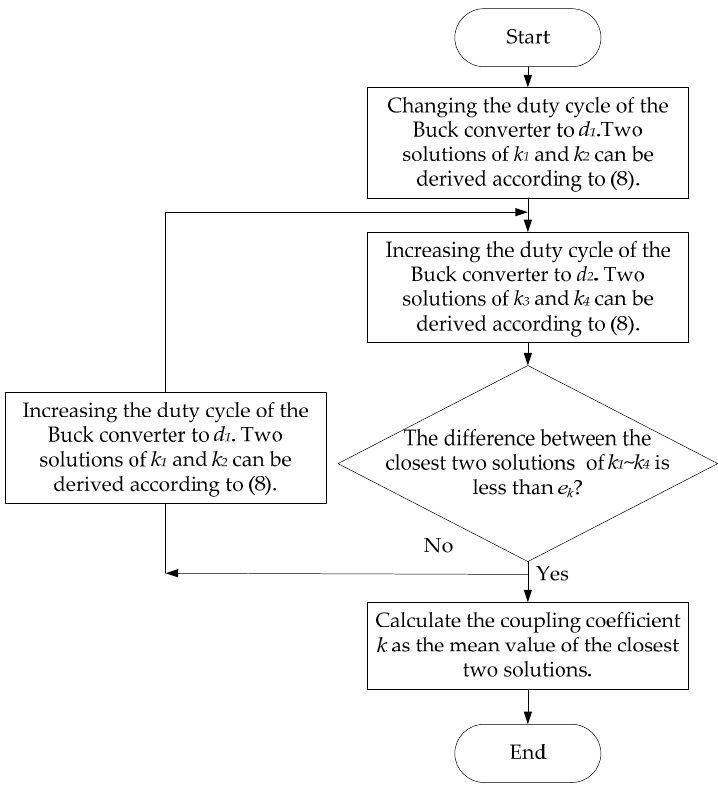
Figure 3. Flowchart of the identification process when considering the two-value issue.